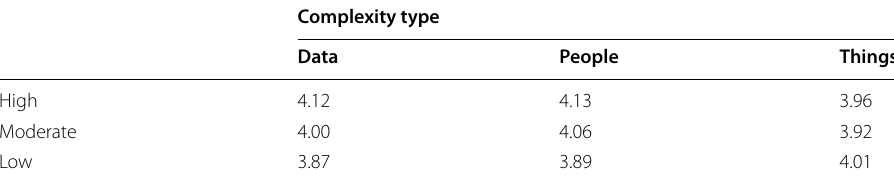
Table 9 Job satisfaction at different levels of occupational complexity, total sample. Source: PIAAC 2012, DOT index, ISCO-08 codes